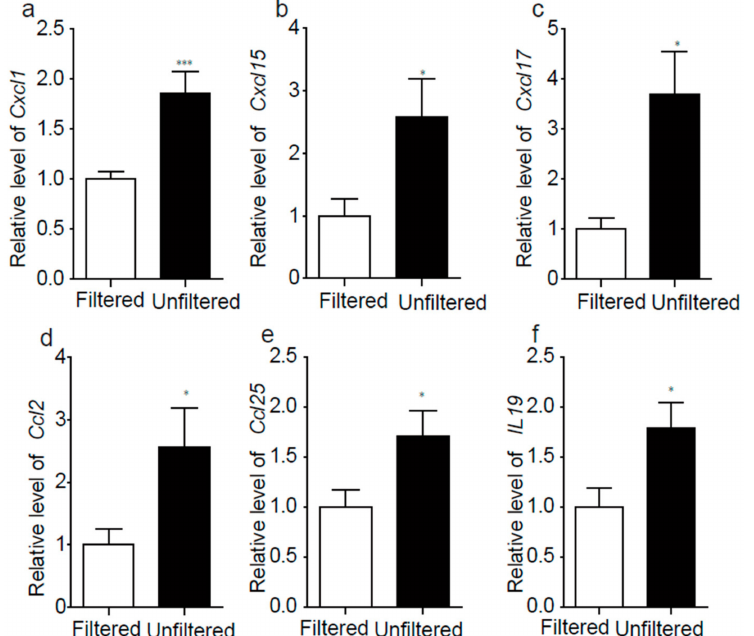
Figure 5. PM 2.5 exposure induced hippocampal cytokine and chemokine activation in mice. The genes expression levels by real-time PCR. The Cxcl1 (( a ), p < 0.01, t10 = 3.693), Cxcl15 (( b ), p < 0.05, t10 = 2.355), Cxcl17 (( c ), p < 0.05, t10 = 3.020), Ccl2 (( d ), p < 0.05, t10 = 2.306), Ccl25 (( e ), p < 0.05, t10 = 2.294), IL19 (( f ), p < 0.05, t10 = 2.428). * p < 0.05; *** p < 0.001. PCR: Polymerase Chain